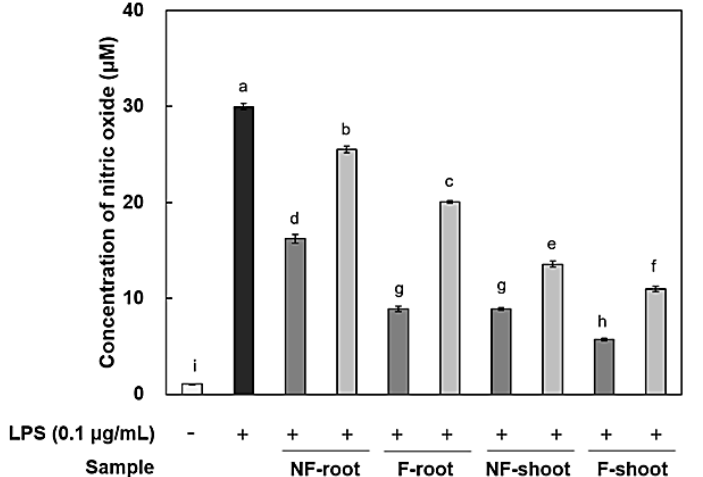
Figure 2. Anti-inflammatory effect in RAW 264.7 cells treated with hydroponic ginseng fermented with Leuconostoc mesenteroides KCCM 12010P. 200 μg/mL; 100 μg/mL. Values are means ± standard deviation of triplicate experiments. Different letters indicate significant differences as determined by Duncan’s multiple range tests ( p < 0.05).